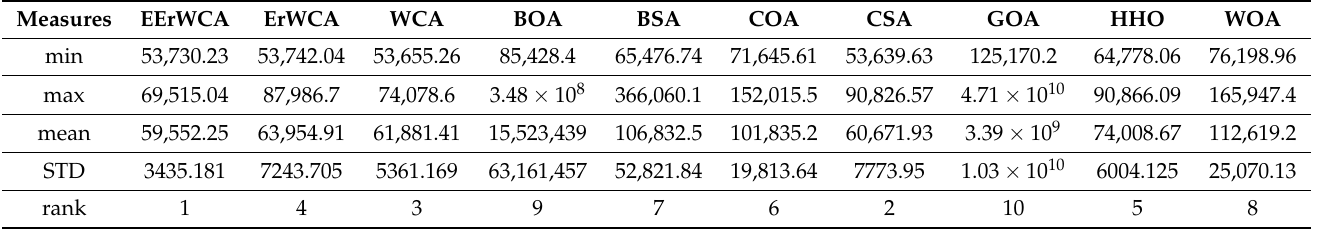
Figure 8. Design of multi-product batch plant. Table 9. Statistical results of EErWCA versus other metaheuristics on multi-product batch